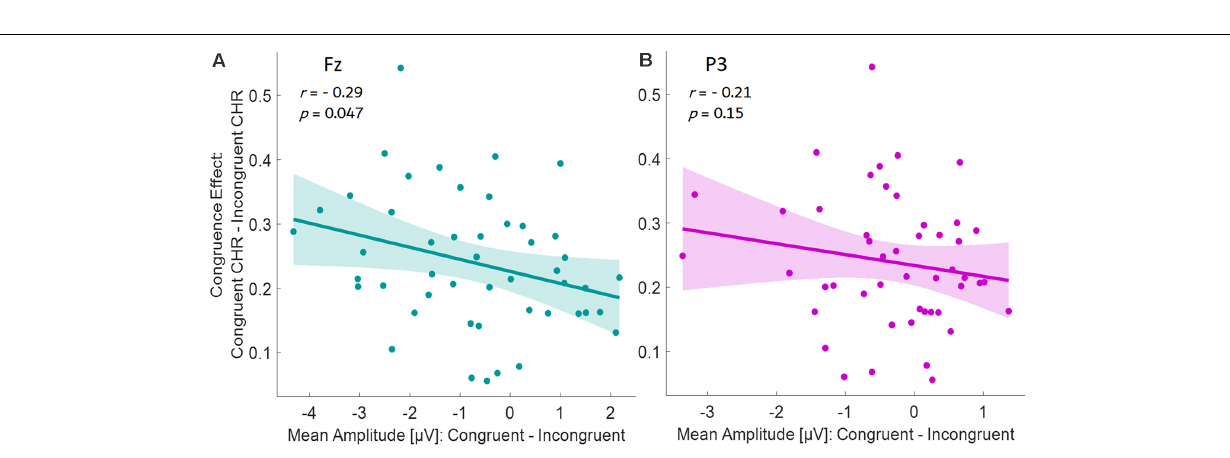
FIGURE 6 | Partial correlations (controlling for age) between the mean ERP amplitudes (Congruent ERP to old items minus Incongruent ERP to old items) as the independent variable, and the memory benefit by congruence (congruent high-confidence CHR minus incongruent high-confidence CHR) as the dependent variable, for the late time window for the electrode (A) Fz, and (B)